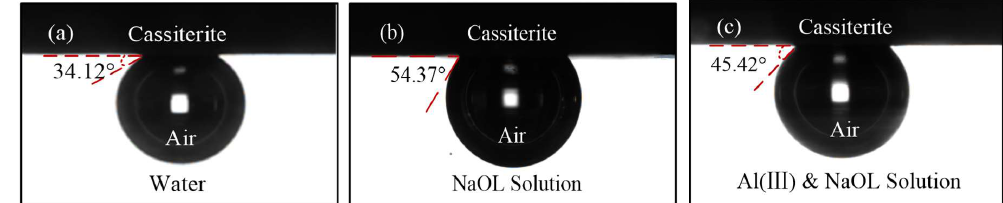
Figure 8. The contact angle of cassiterite in different solutions: ( a ) water; ( b ) sodium oleate solution of 5 × 10 −5 mol/dm 3 ; ( c ) mixture of Al (III) ions and sodium oleate solution (3 × 10 −4 mol/dm 3 and 5 × 10 −5 mol/dm 3 , respectively).